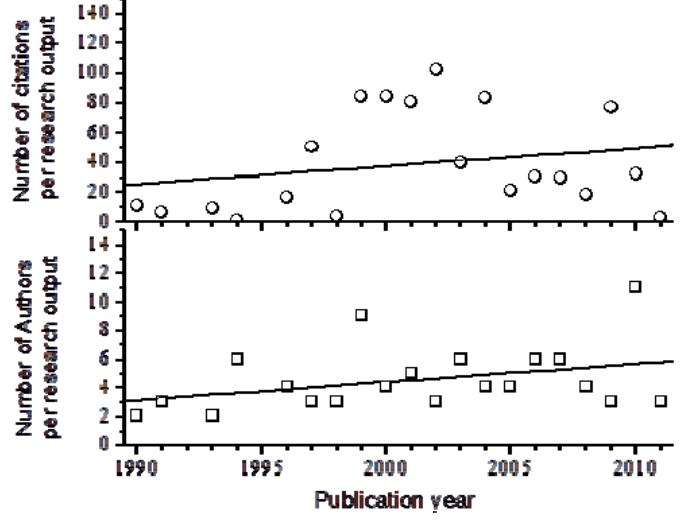
Figure 10. The number of co-authors and citations for research output of the most cited articles in each year published since 1990 (see Table